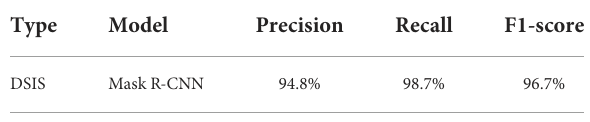
TABLE 1 Mask R-CNN test results for the whole area of disease spots and insect spots.